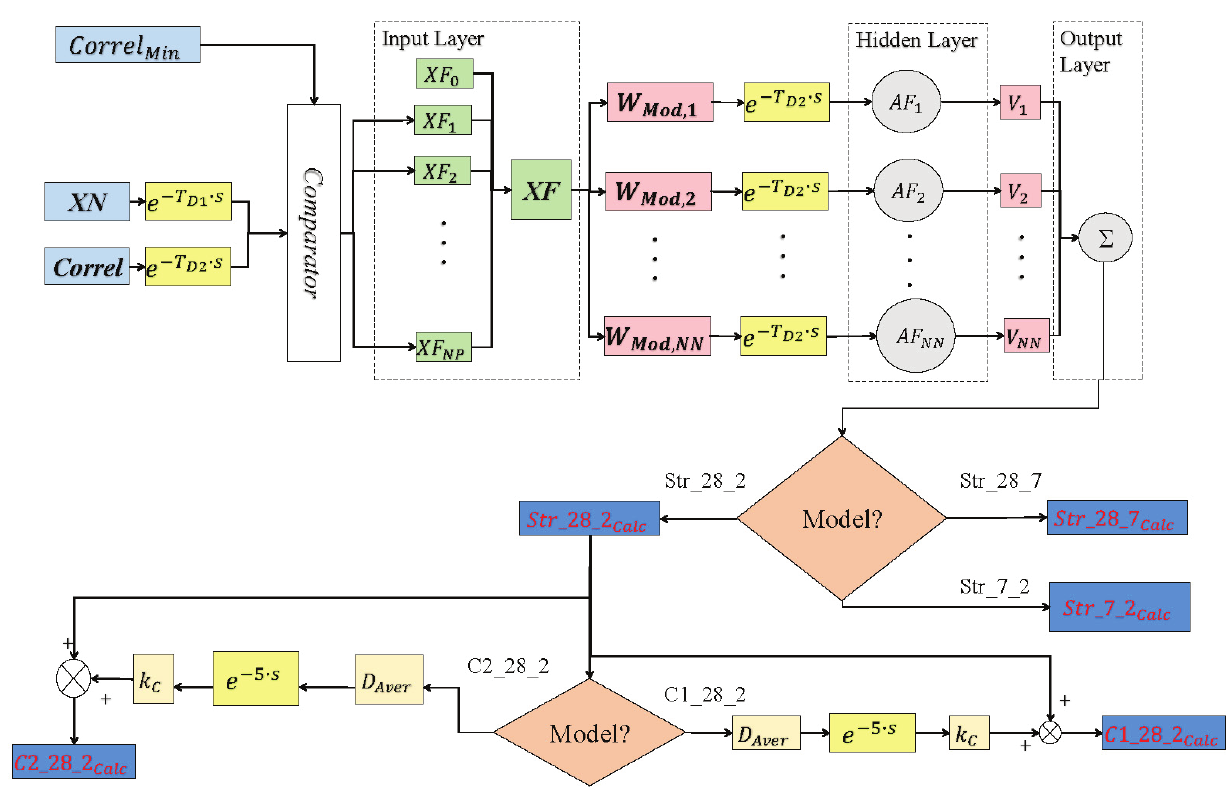
Fig. 2 – Block diagram of dynamic